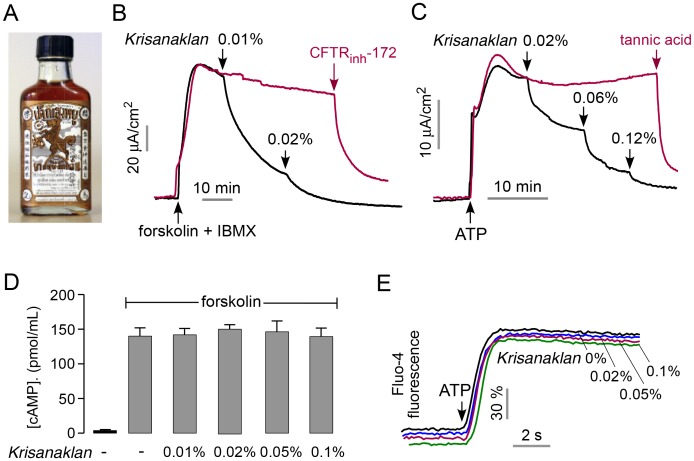
Krisanaklan inhibits intestinal cAMP and Ca2+-regulated Cl− channels.A. Krisanaklan, a commonly used Thai herbal antidiarrheal remedy. B. Short-circuit measurement in T84 cells. Representative current trace showing Krisanaklan inhibition of forskolin (20 µM) and IBMX (100 µM)-stimulated CFTR Cl− conductance (black). Parallel study done without added Krisankalan (red) showing inhibition by CFTRinh-172. C. Krisanaklan inhibition of ATP (100 µM)-stimulated CaCC Cl− current in T84 cells (black). CFTR was inhibited by pre-addition of CFTRinh-172 (20 µM). Parallel study done without added Krisankalan (red), showing inhibition by tannic acid. Data in B and C representative of 4 sets of measurements. D. Cyclic AMP concentration in T84 cell homogenates under basal condition and 30 min after treatment with 20 µM forskolin alone or together with Krisanaklan (mean ± S.E., n = 4). E. Cytoplasmic [Ca2+] measured by Fluo-4 fluorescence under basal conditions and following ATP (100 µM). Cells were pretreated with different concentrations of Krisanaklan. Data were slightly displaced in the y-direction to visualize individual curves.